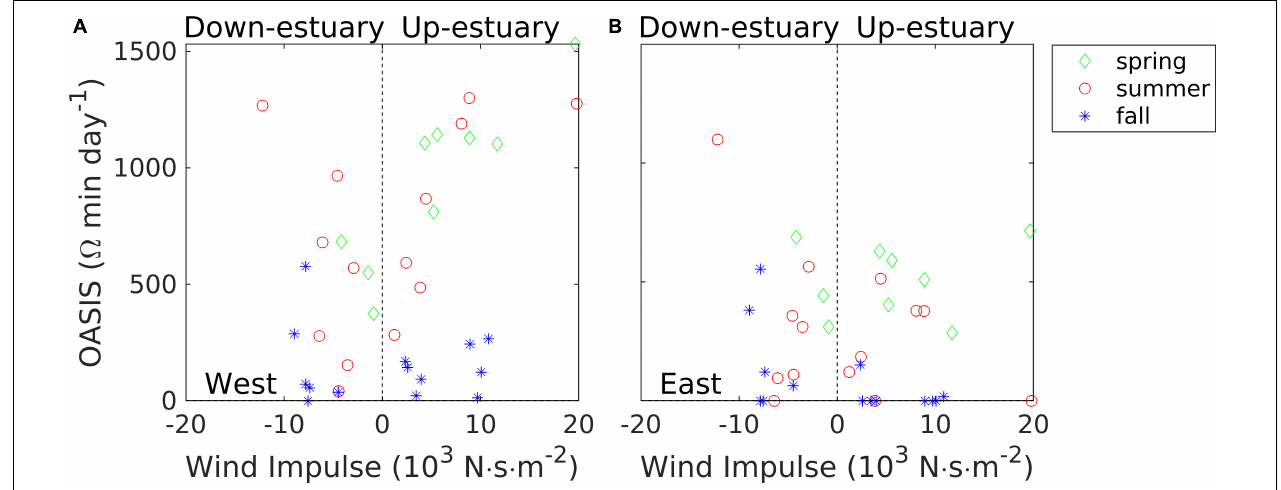
FIGURE 13 | OASIS (Ocean Acidification Stress Index for Shellfish) in bottom waters at the western shoal (A) and the eastern shoal (B) locations in the mid-Bay cross-section. Green diamonds for spring, red circles for summer, and blue stars for fall.